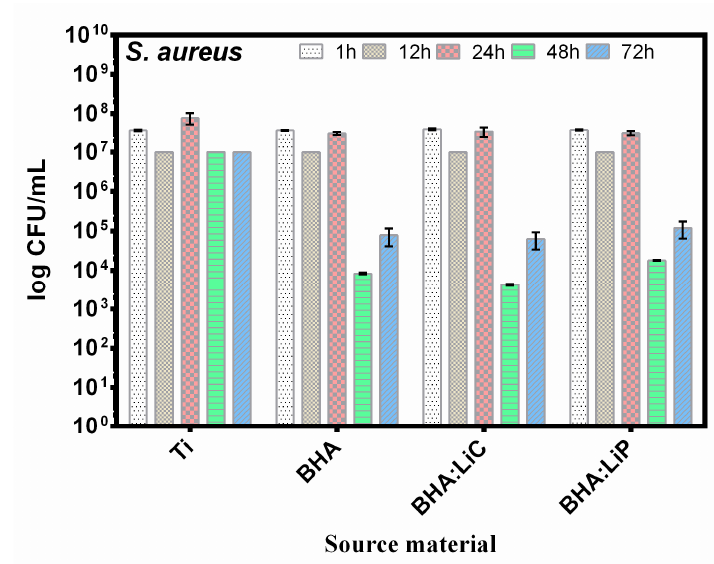
Figure 9. Graphic representation of the logarithmic values of S. aureus biofilm cells developed on the surfaces of Ti, bovine hydroxyapatite (BHA), and doped BHA coatings, at di ff erent time intervals (1–72 h) [11]. Slight modifications of the acronyms from the original figure were done for uniformization with the sample codes used in this review.